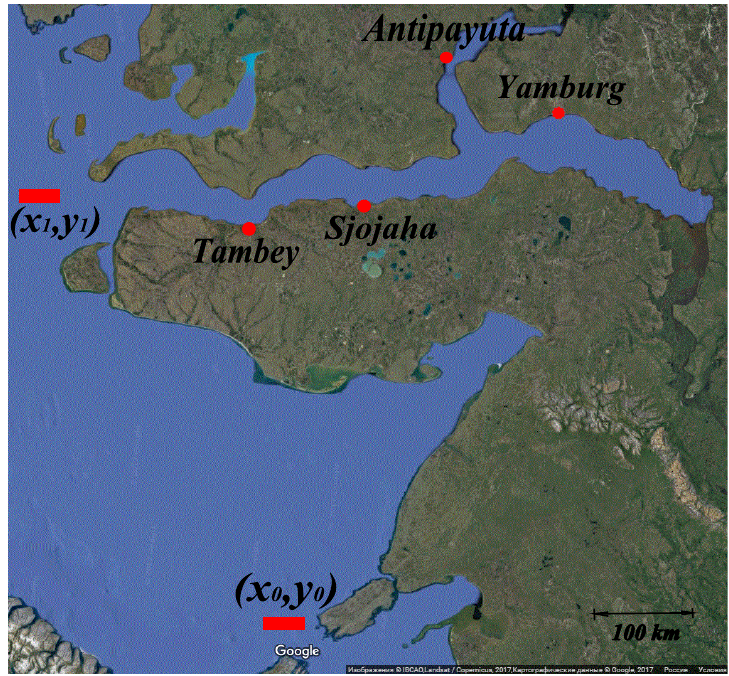
Figure 4. Geographical area of the example under consideration showing the unloading points.